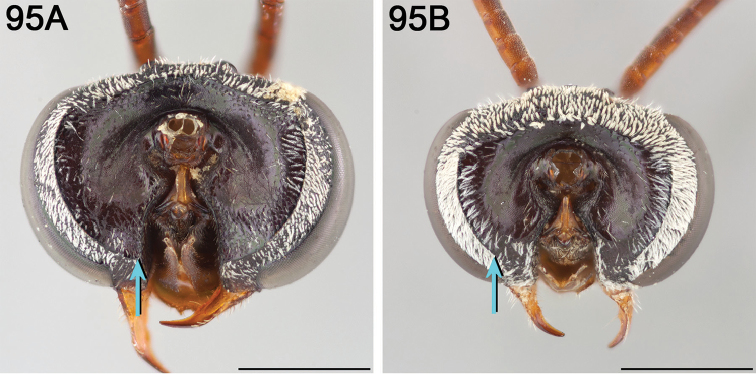
Head (in posterior view) removed from female A
E.
ainsliei, in which the preoccipital ridge joins the hypostomal carina, and B
E.
attenboroughi holotype, in which the preoccipital ridge does not join the hypostomal carina. Scale bars 1 mm. Note that these features can be seen without having to detach the head.